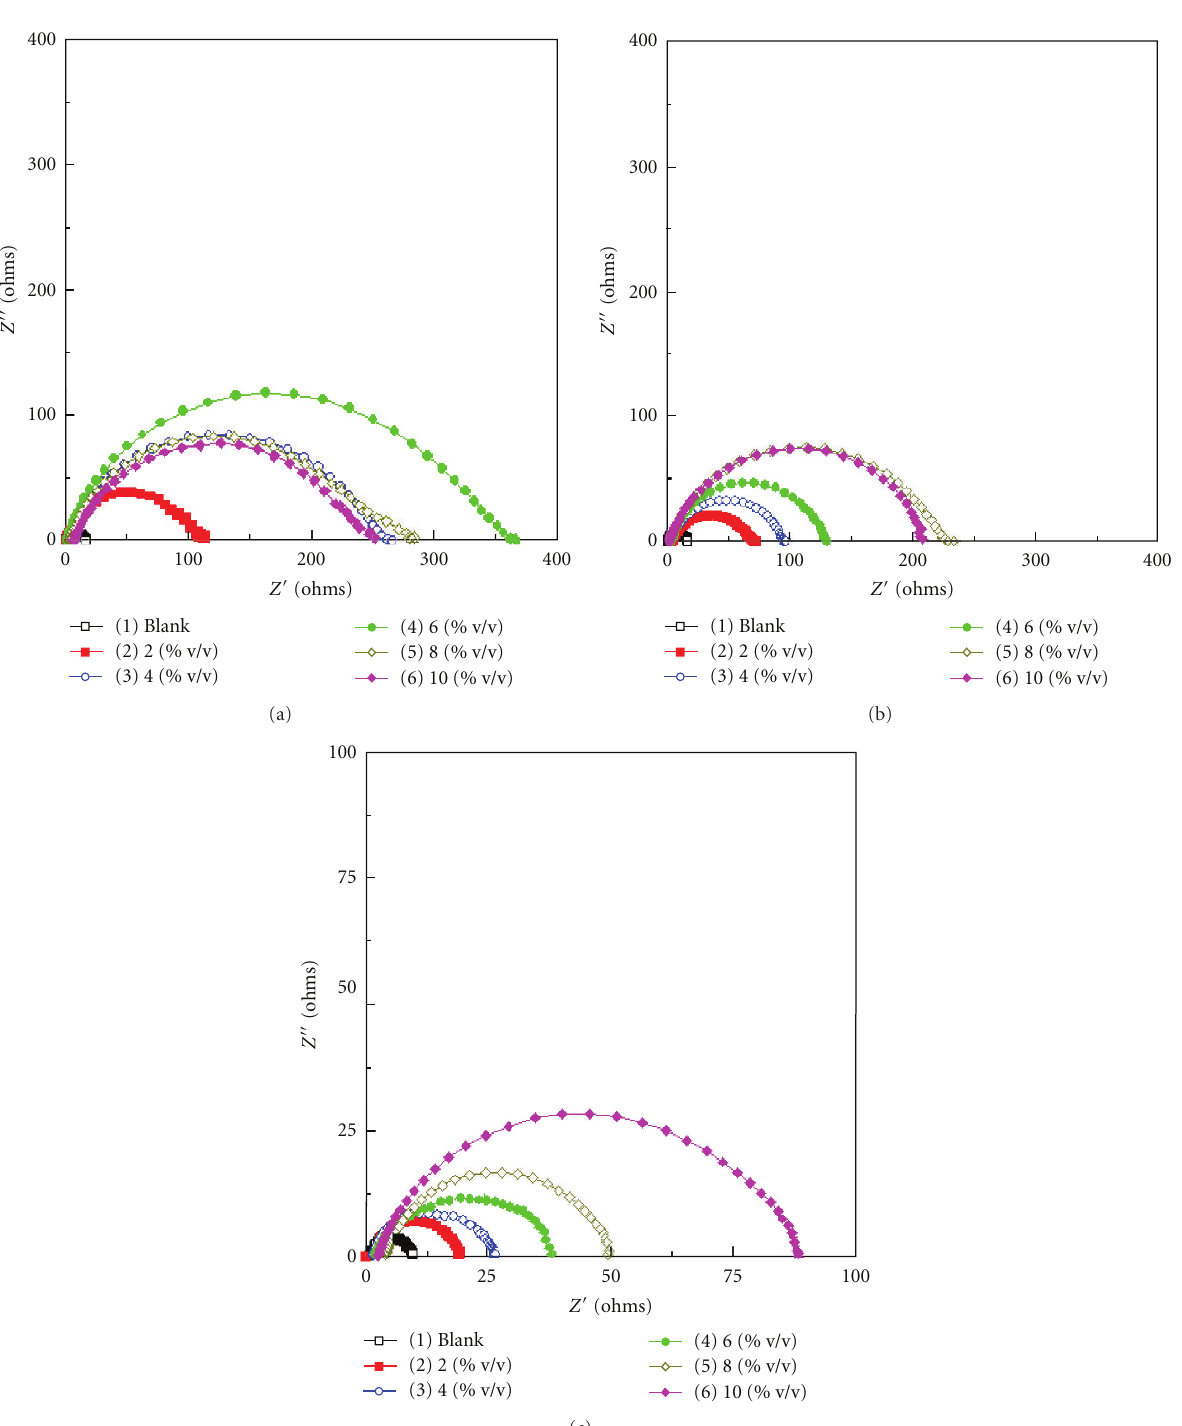
Figure 2: Impedance diagrams for mild steel in 1N HCl solution in the absence and presence of various concentrations of the plant extract (a) Ocimum sanctum , (b) Aegle marmelos , and (c) Solanum trilobatum